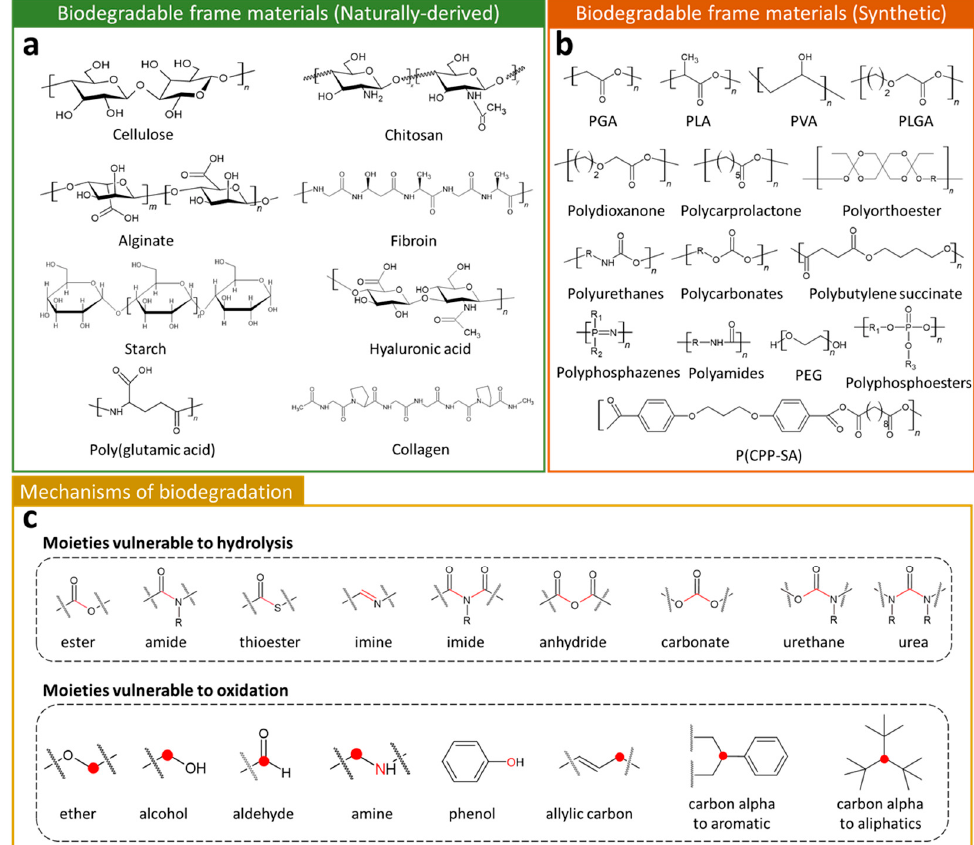
Figure 2. Chemical formulas of ( a ) naturally-derived and ( b ) synthetic biodegradable polymers. ( c ) Chemical structural formulas of functional groups capable of hydrolysis or oxidation reactions. Red line, circle, or character highlight the specific position in moieties.